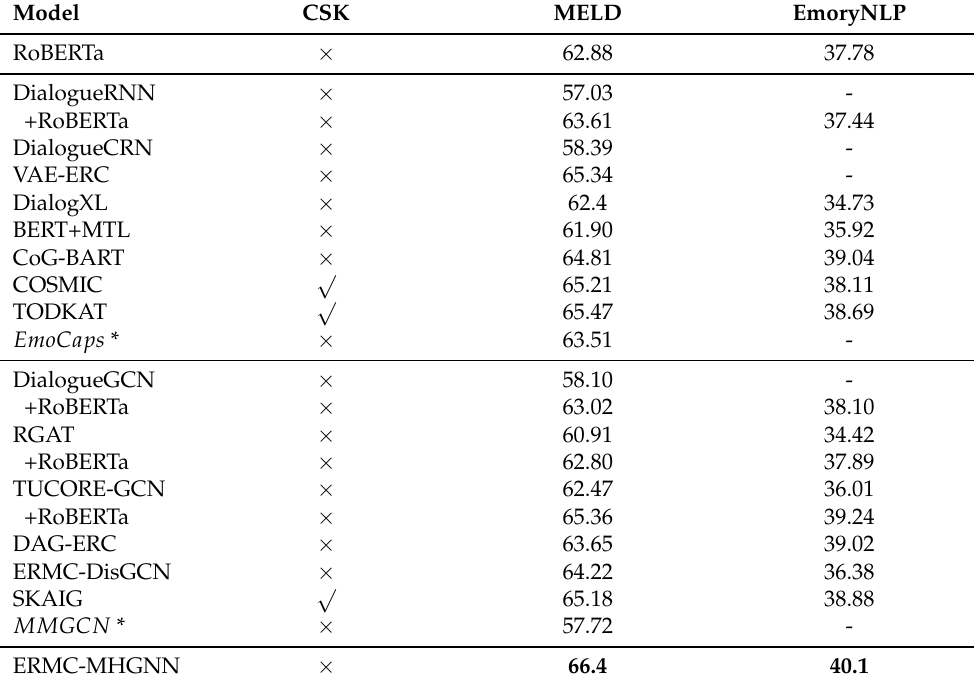
Table 3. Overall performance on the two datasets. ’-’ signifies that no results were reported for the given dataset. ’CSK’ stands for a model that introduced commonsense knowledge, ’ represent using ’CSK’ and not using ’CSK’ respectively. ’*’ represents the results of the model in the text-only